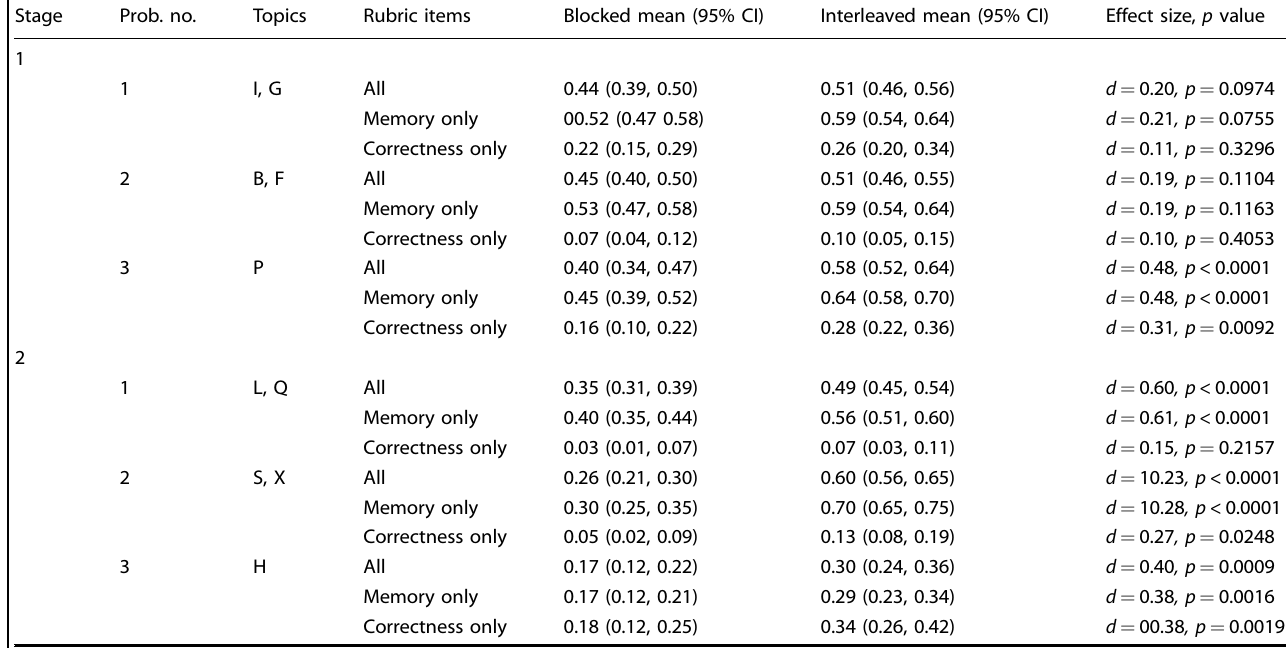
Table 3. Criterial test individual problem results. Stage Prob.